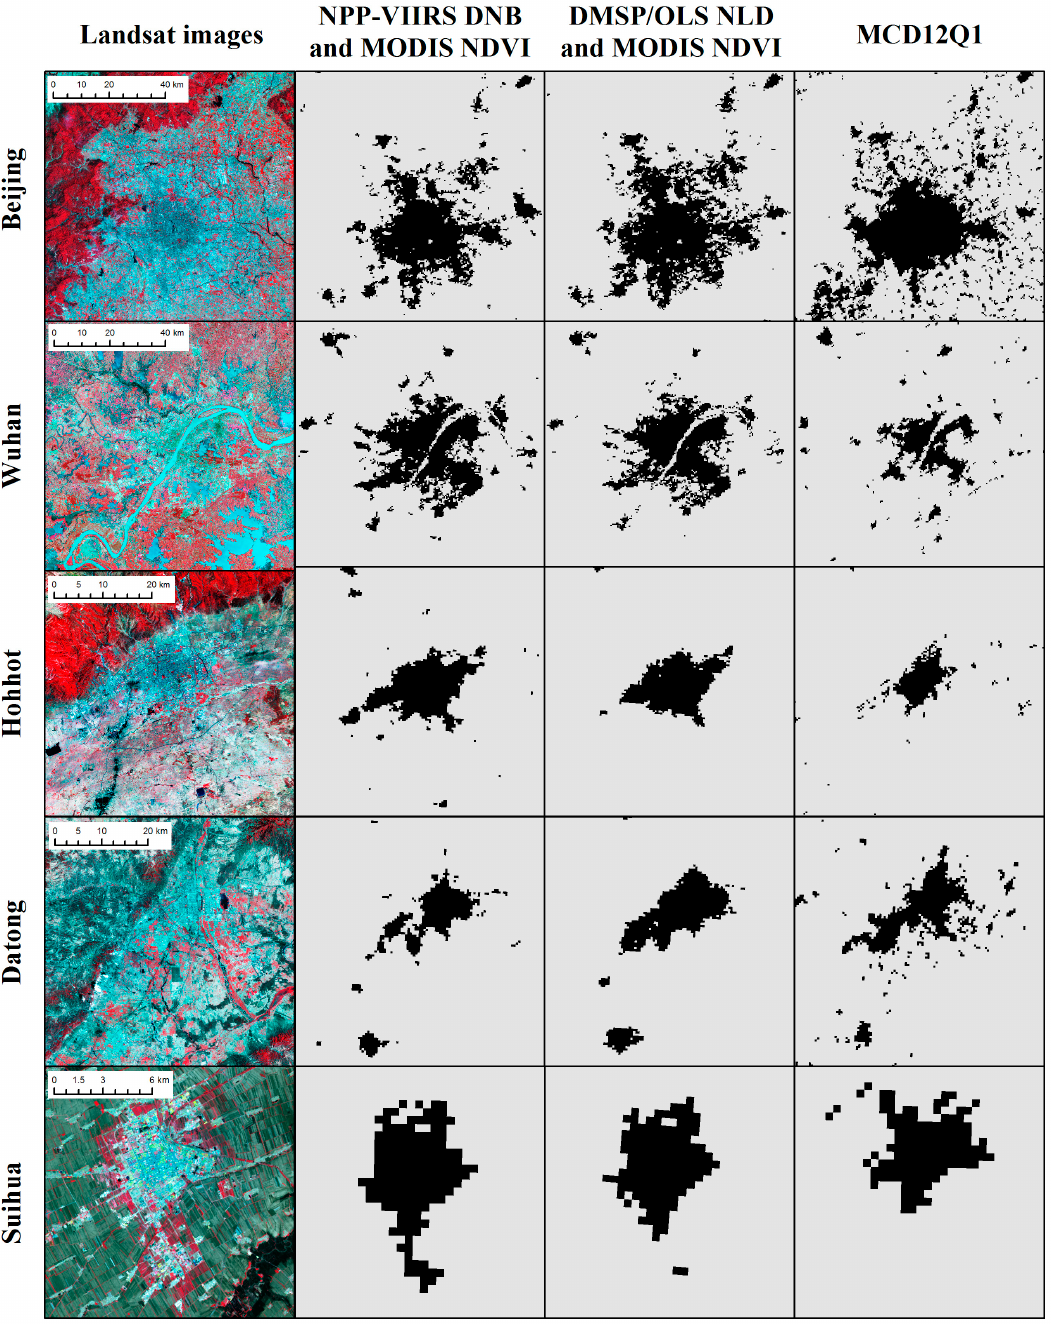
Figure 8. Urban extent of five cities (Beijing, Wuhan, Hohhot, Datong and Suihua) in different productions. The Day/Night Band of the Visible Infrared Imaging Radiometer Suite on the Suomi National Polar-orbiting Partnership Satellite (NPP-VIIRS DNB), the the Defense Meteorological Satellite Program/Operational Linescan System Nighttime Light Data (DMSP/OLS NLD), the Normalized Difference Vegetation Index from the Moderate Resolution Imaging Spectroradiometer products (MODIS NDVI) and the public land cover datasets in MODIS products (MCD12Q1) are collected in 2012. Landsat images are collect between October 2012 and August 2013 for the best display effect.